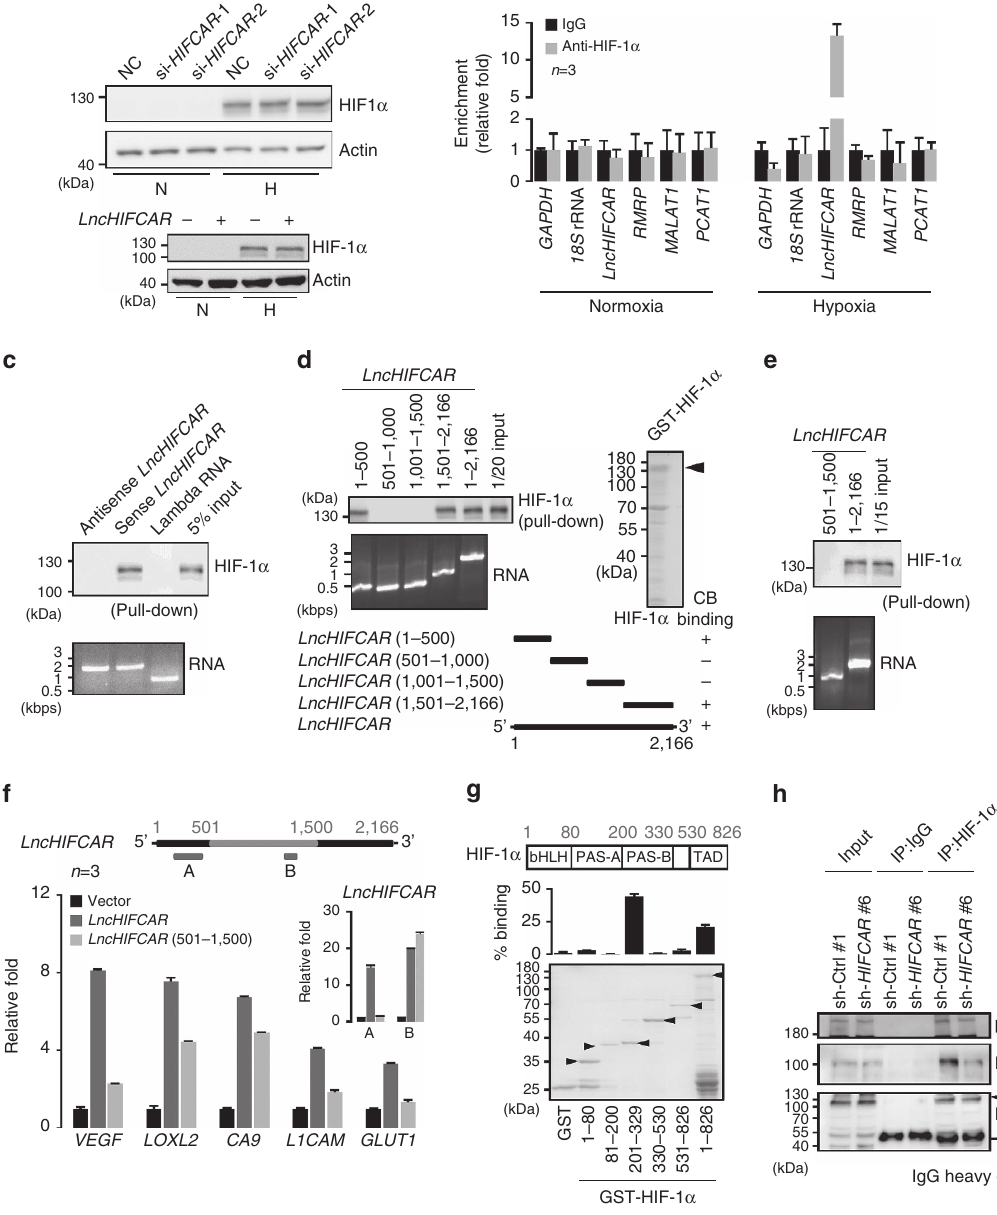
functional domains and GST-HIF-1 a variants are shown at the top. The Coomassie Blue staining showed loading of the proteins and arrowheads mark the GST-HIF-1 a truncates. LncHIFCAR RNA were pulled down by GST-fusion proteins pre-bound on glutathione-Sepharose beads, followed by qRT–PCR detection of LncHIFCAR RNA retrieved as presented as percentage relative to input RNA. bHLH, basic helix–loop–helix; PAS, Per-ARNT-Sim; TAD, transactivation domain. ( h ) LncHIFCAR facilitates HIF-1 a complex formation. HIF-1 a was immunoprecipitated from hypoxic vector control or LncHIFCAR knockdown SAS cell extracts. Co-immunoprecipitation of p300 and HIF-1 b was reduced in LncHIFCAR knockdown cells. Graphs show mean ± s.d. n , the number of independent experiments